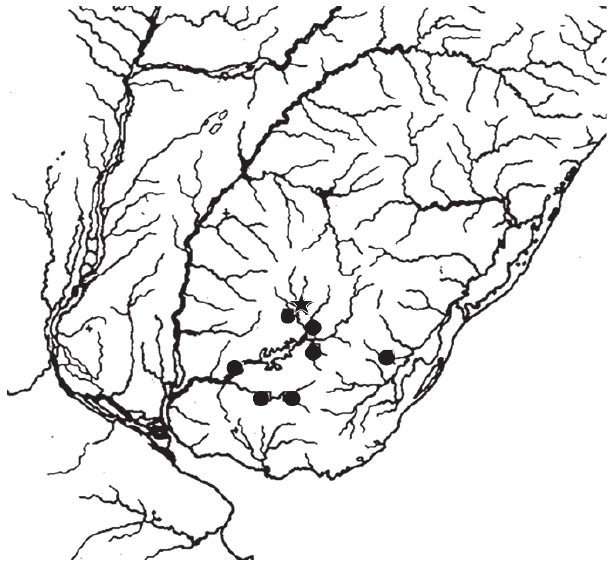
Fig. 3. Distribution of Gymnogeophagus tiraparae . Star = type